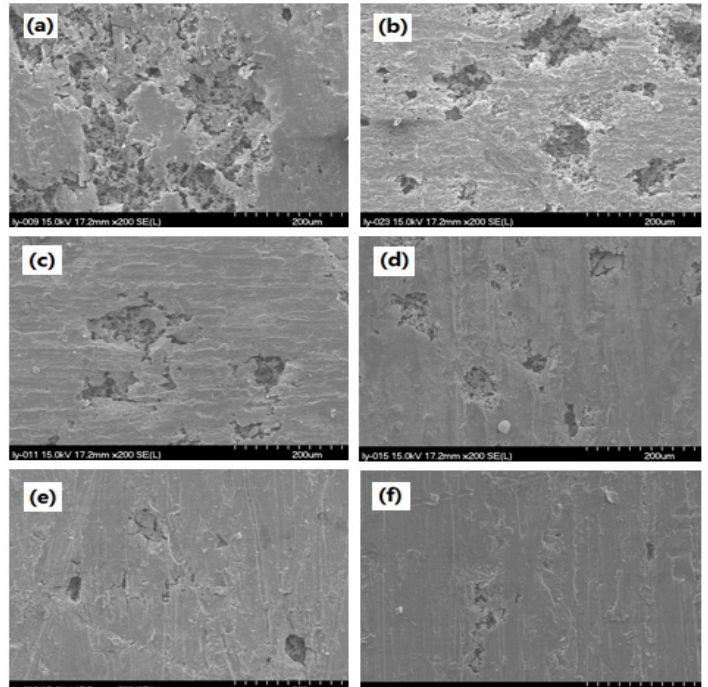
Figure 3. Scanning electron microscopy (SEM) images (20 kV, 9800, 38 lm, ×200) of six samples for electrochemistry measurements: ( a ) f-GS; ( b ) f-GSTT ; ( e ) f-GSTT and ( f ) f-GSTT ( d ) f-GSTT 15% 20% 25%